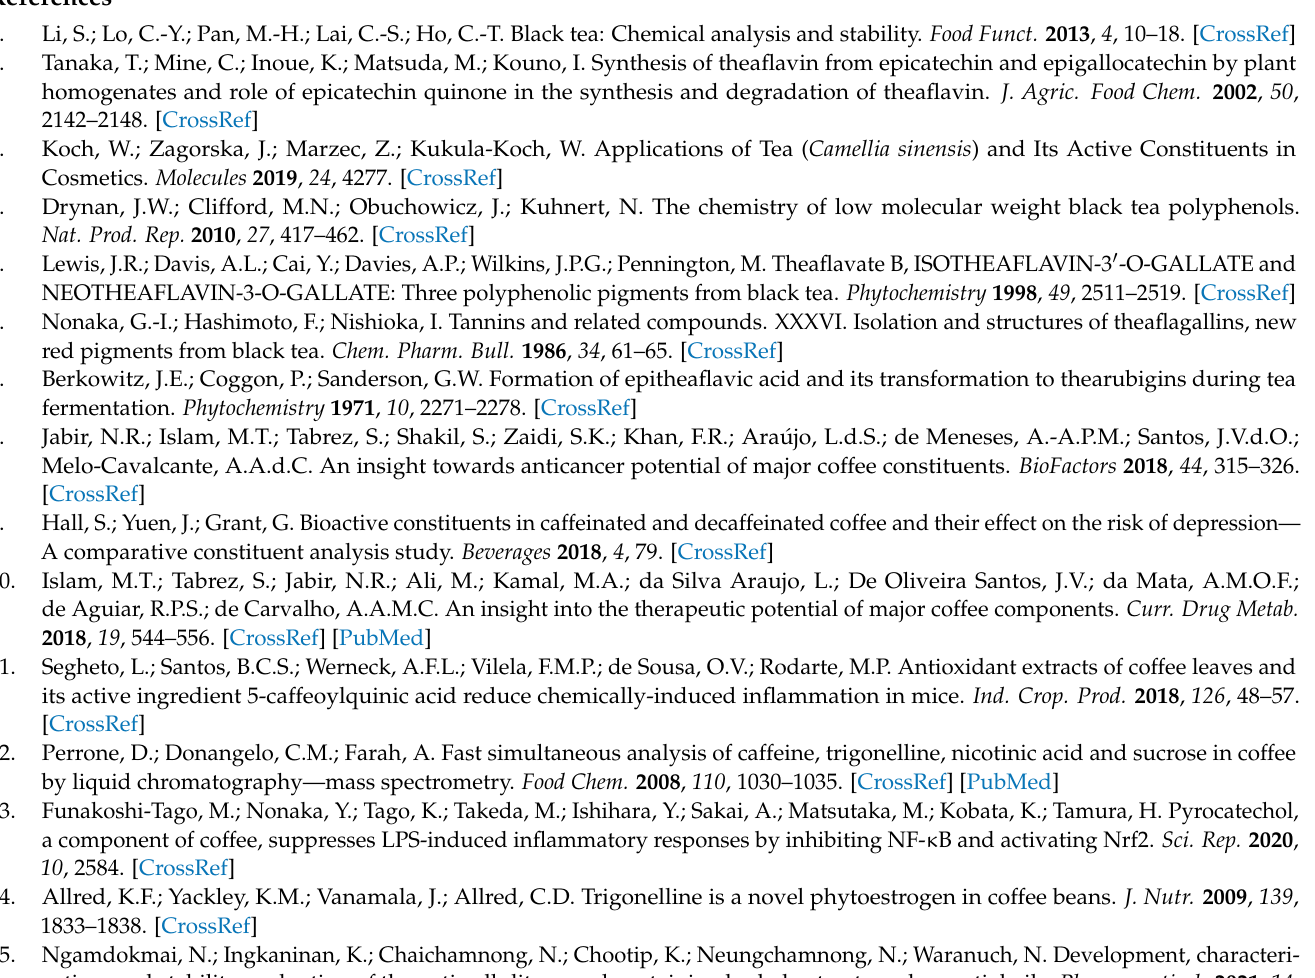
ical appearances of blank hydrogels, Figure S3: Physical observation of gelling during optimization Figure S4: Effect of media on hydrogel integrity, Table S1: Optimization of PAA amount based on physical properties, Table S2: Optimization of Black tea extract loading with APS and MBA amounts, Table S3: Model-fitting of the release of tea and tea-milk hydrogels, Table S4: Model-fitting of